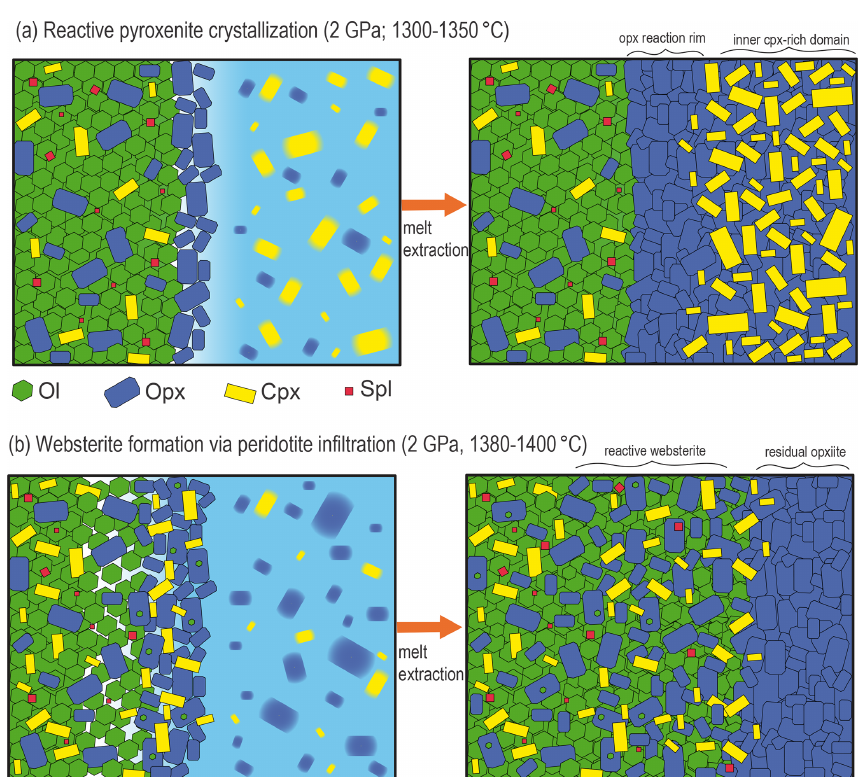
Figure 10. Representative sketches illustrating the nature and results of pyroxenite–peridotite interaction at 2GPa as a function of different thermal status. (a) At 1300–1350 ◦ C, the interaction between subsolidus peridotite and partially molten pyroxenite leads to reaction crys- tallization of the orthopyroxenite layer from the contact of the peridotite towards the inner pyroxenite. Melt–peridotite reaction is confined at the pyroxenite–peridotite boundary, and chemical changes are mostly observed in the phases of the crystal mush. Once residual melt is fluxed away or extracted by compaction, composite layers of orthopyroxenite or websterite form at the periphery and clinopyroxene-rich central domains. (b) At higher temperature (1380–1400 ◦ C), incipient or low degrees of peridotite partial melting enhance the pyroxenite- derived melt infiltration that significantly modifies the mineralogy and chemistry of the host peridotite. After extraction of residual melts, the pyroxenite–peridotite interaction forms olivine-bearing (spinel) websterite coupled with the orthopyroxene-rich refractory